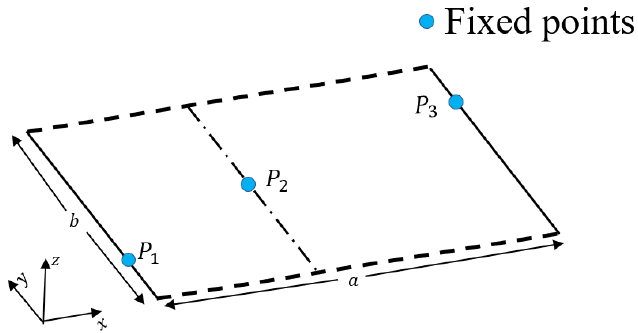
Figure 11. Plate supported by three rigid